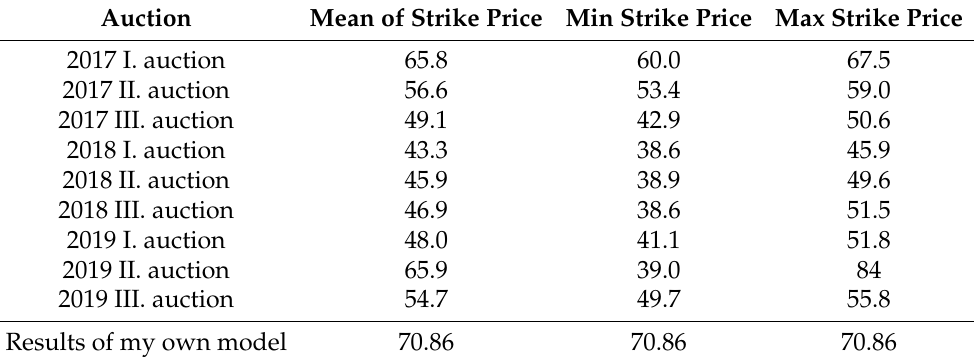
Table 7. Results of the German PV auctions and of my own modelling for pay-as-bid rules, 2017–2019, source: [44] and own